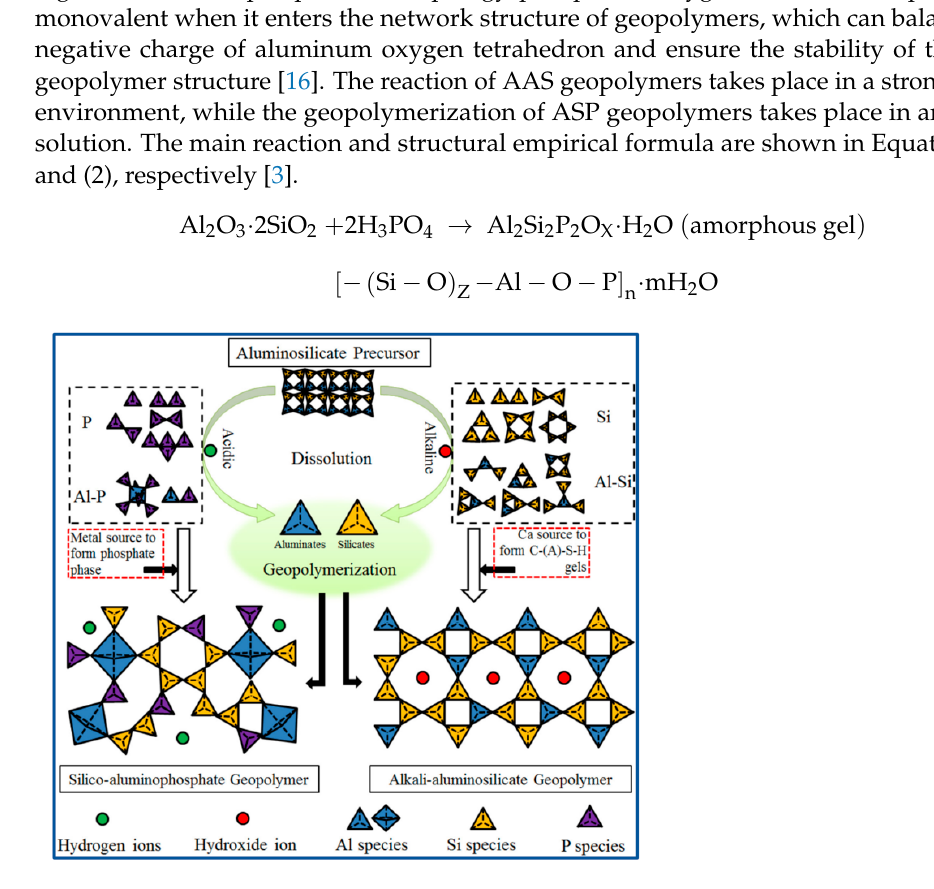
Figure 1. Reaction process of aluminosilicate precursors forming geopolymer under alkaline and acidic conditions [3].